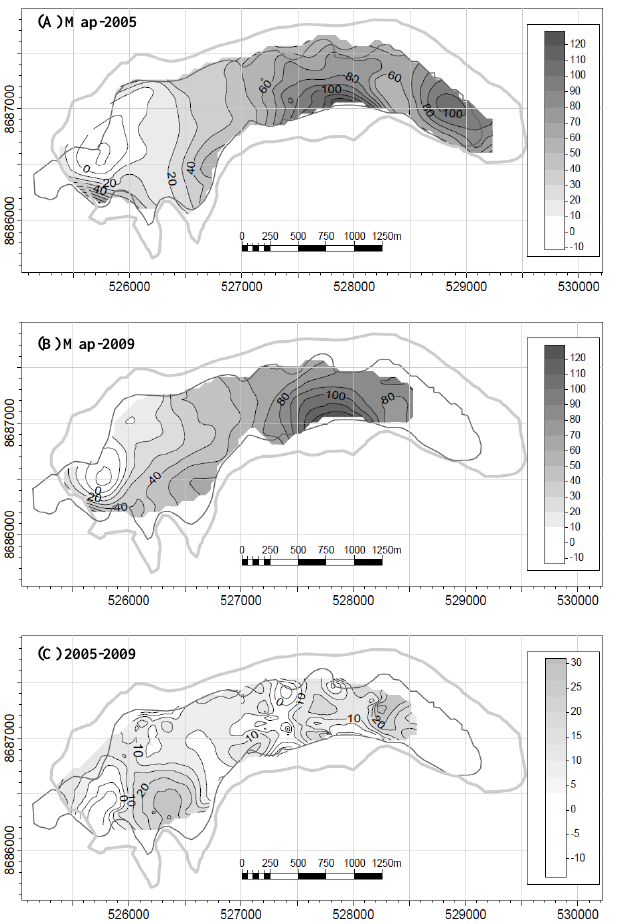
Fig. 6. The change in surface elevation and outline of Tellbreen. Norwegian Polar Institute A7 map, 1:100.000 series outline (light grey) and 2005 area covered by GPS measurements (dark grey).